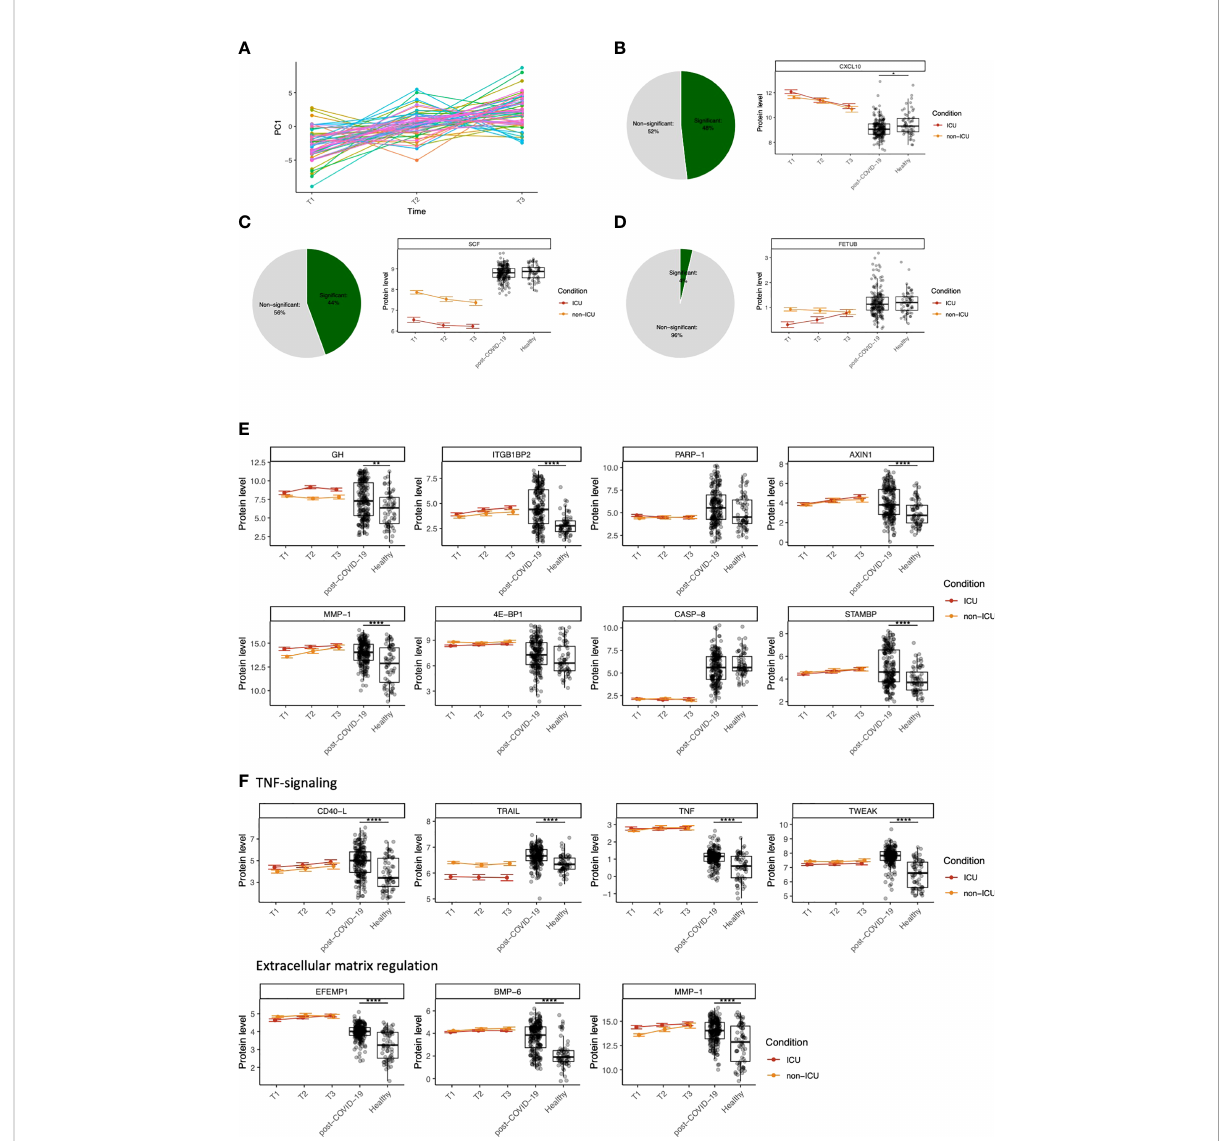
FIGURE 4 Dynamic changes in circulating proteins can be used to monitor disease severity in COVID-19 and serve as potential therapeutic targets. (A) ANOVA-PCA on the protein concentrations of the fi rst three time-points after COVID-19 hospitalization in cohort 2. The time-points are taken at 48-hour intervals, and thus represent the fi rst six days after hospitalization. 61 patients were selected who were consistently samples three times. The mean protein abundance per patient was subtracted from the measurements for these patients. The fi rst principal component of this data was plotted against the time. (B) Representative example of a protein (CXCL10) that signi fi cantly differs over time during COVID-19 hospitalization, both in ICU and non-ICU patients. The pie chart indicates the proportion of proteins found to be signi fi cant for this effect. Red and orange colors indicate protein concentrations in COVID-19 ICU patients and non-ICU patients, respectively. (C) Representative example of a protein (stem cell factor, SCF) that signi fi cantly differs between conditions (ICU and non-ICU). The pie chart indicates the proportion of proteins found to be signi fi cant for this effect. Red and orange colors indicate protein concentrations in COVID-19 ICU patients and non-ICU patients, respectively. (D) Representative example of a protein (fetuin B precursor, FETUB) that signi fi cantly differs over time and between conditions. The pie chart indicates the proportion of proteins found to be signi fi cant for this effect. Red and orange colors indicate protein concentrations in COVID-19 ICU patients and non-ICU patients, respectively. (E) Longitudinal dynamics of heterogeneous proteins in post- COVID-19 individuals. The variance of normalized protein abundance values was calculated and the top eight were selected for visualization. Five out of eight proteins were signi fi cantly upregulated in post-COVID-19 individuals as indicated by the signi fi cance stars. (F) Longitudinal dynamics of proteins related to TNF-signaling and regulation of the extracellular matrix. These proteins were selected based on their highly signi fi cant differential abundance in post-COVID-19 individuals compared to healthy individuals. In all fi gures, signi fi cance is shown when the protein is signi fi cantly differentially expressed in post-COVID-19 individuals compared to healthy individuals: *adj. p < 0.05, **adj. p < 0.01, ***adj. p < 0.001, ****adj. p. < 0.0001. Boxplot center line: median, box limits: 1 st and 3 rd quartiles. Whiskers: 1,5 x interquartile range. For the hospitalized patients, error bars indicate standard